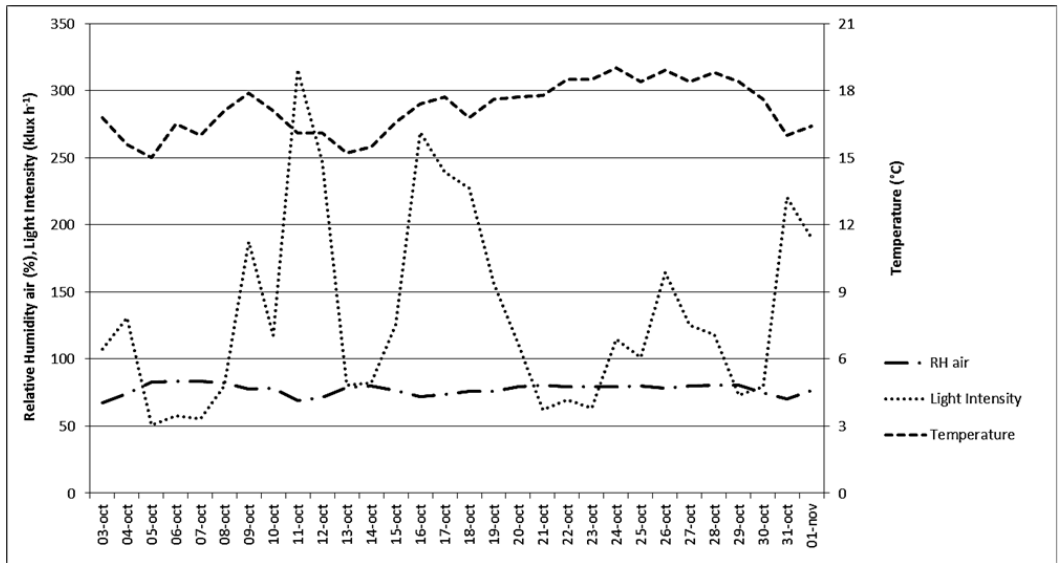
Agronomy 2020 , 10 , x FOR PEER REVIEW Figure A1. Greenhouse environmental conditions during the autumn lettuce growing cycle.